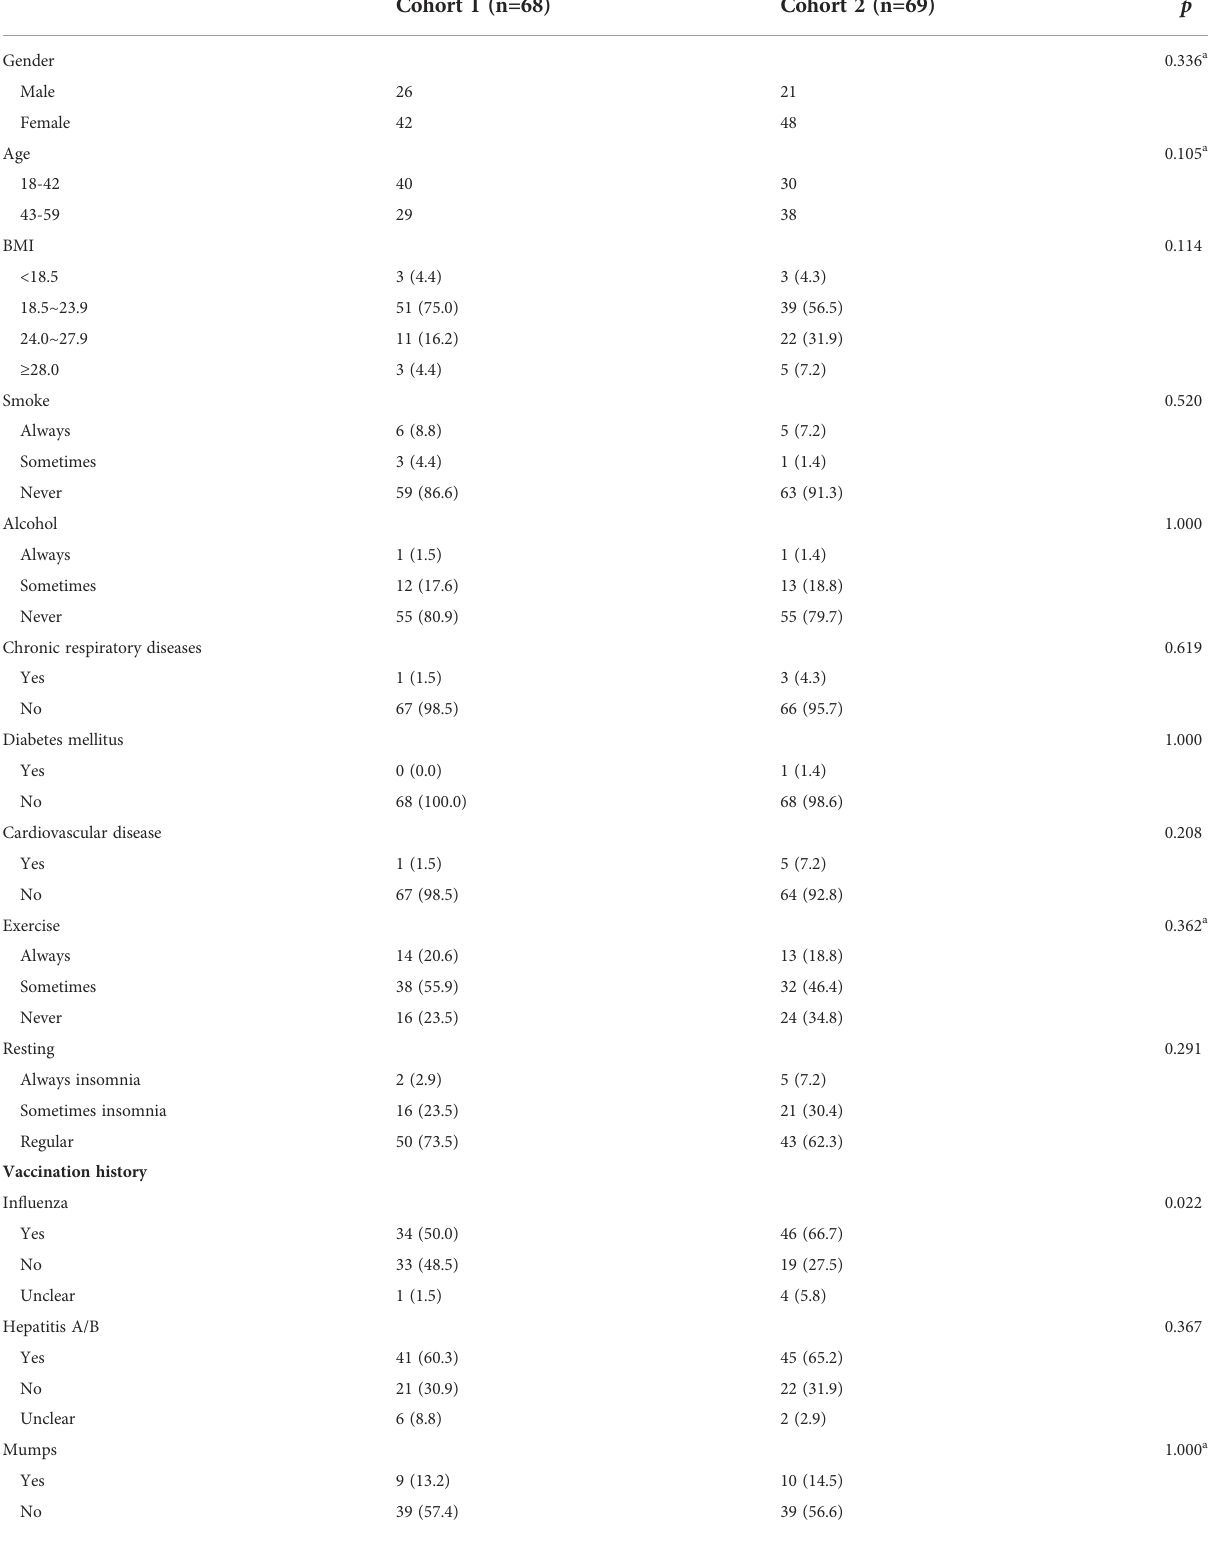
TABLE 1 Comparison of baseline characteristics between the two vaccine